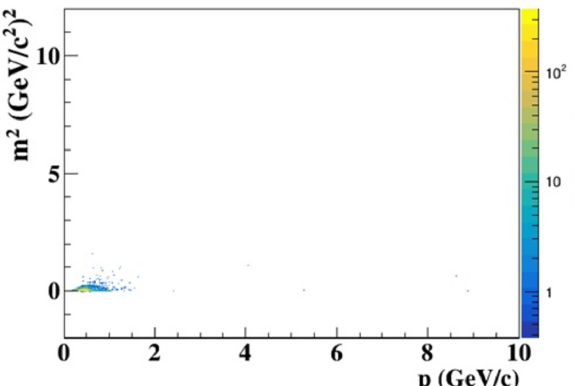
Figure 2. [Color online] The dependences of the median value ∆ E / ∆ x from the particle momentum for a) signal ( 3 He, 4 He), thermal deuterons and tritons and b) UrQMD tracks